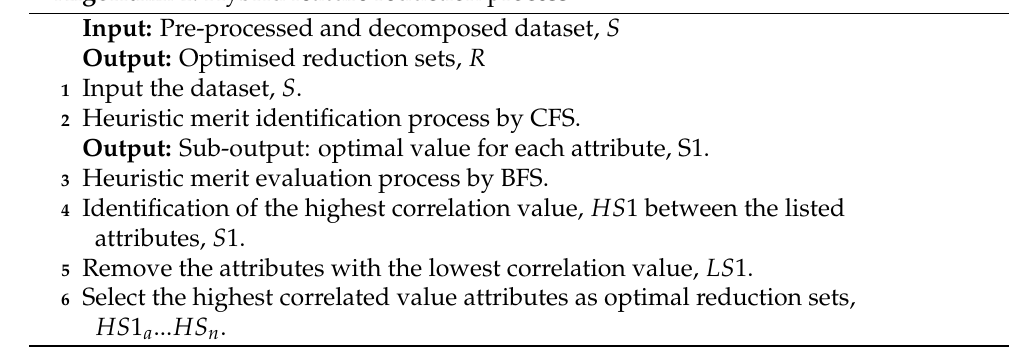
Algorithm 1: Hybrid feature reduction